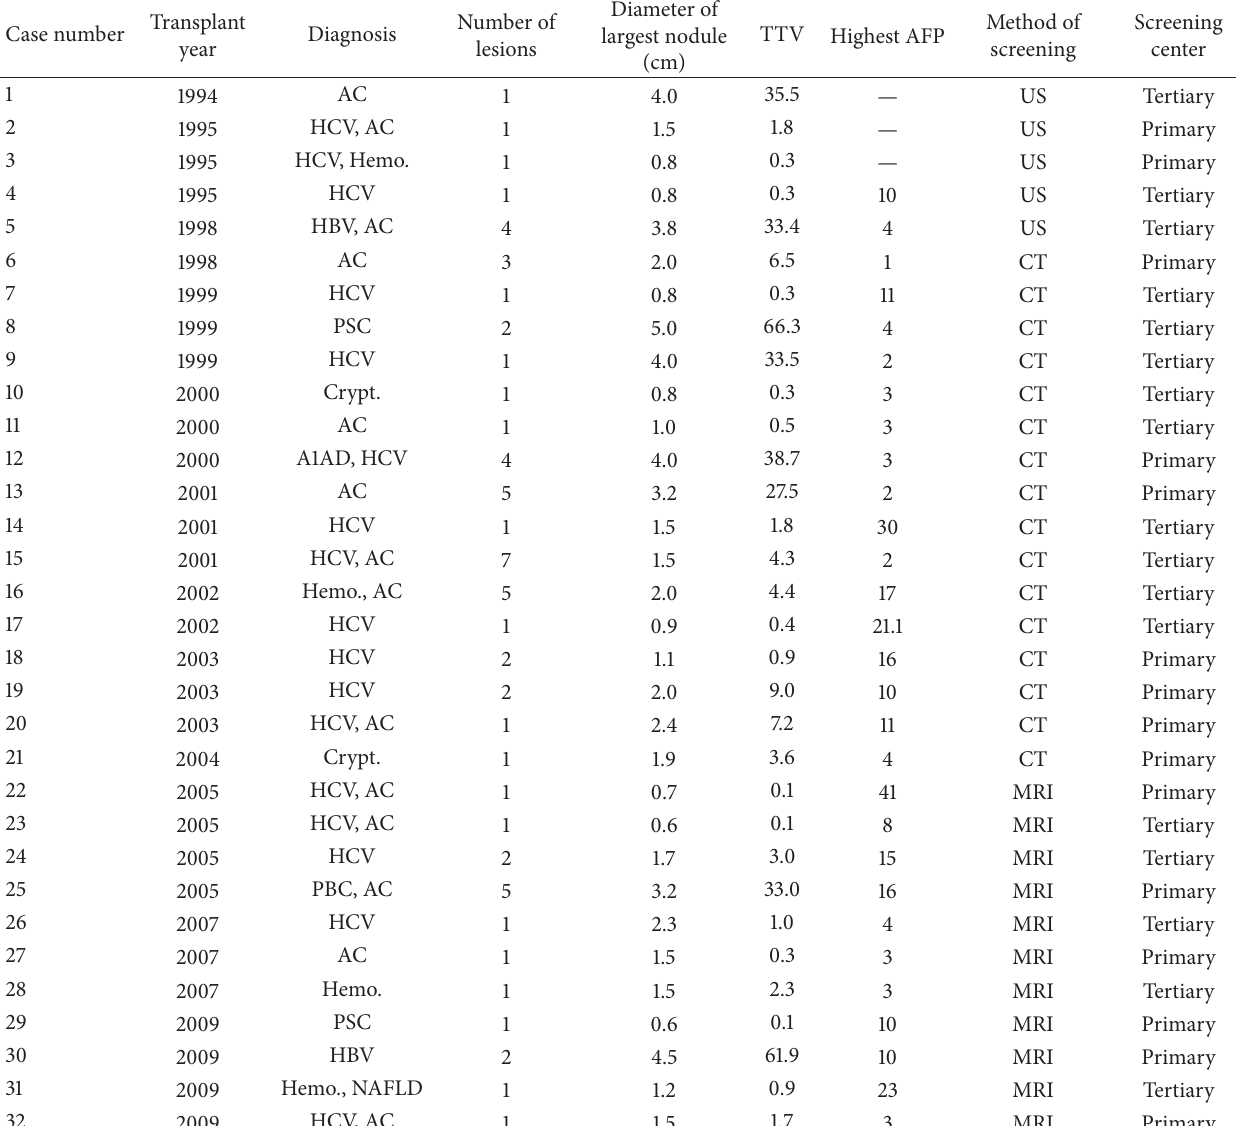
Table 2: Characteristics of iHCC